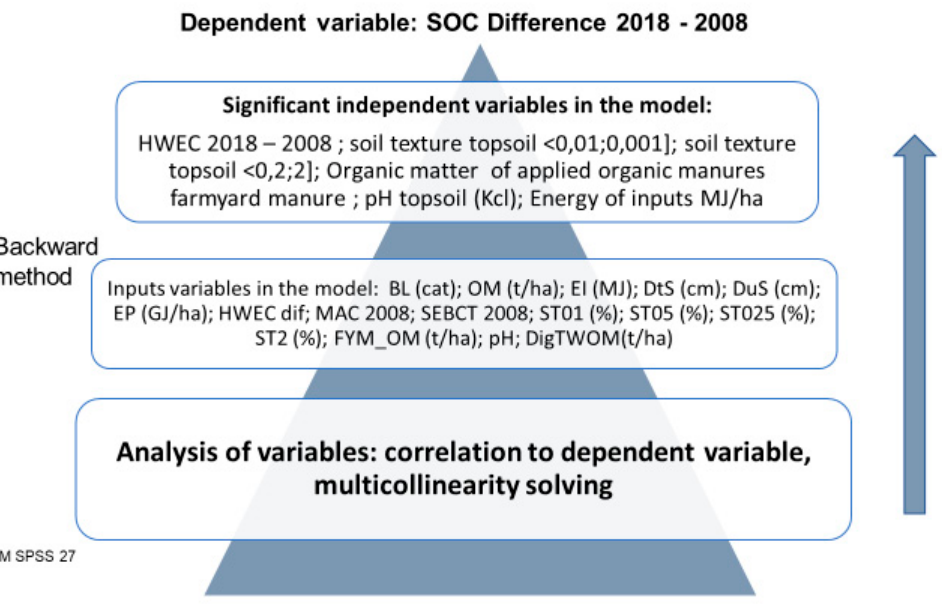
Figure 7. Model 3: SOC Difference between the years 2018 and 2008.